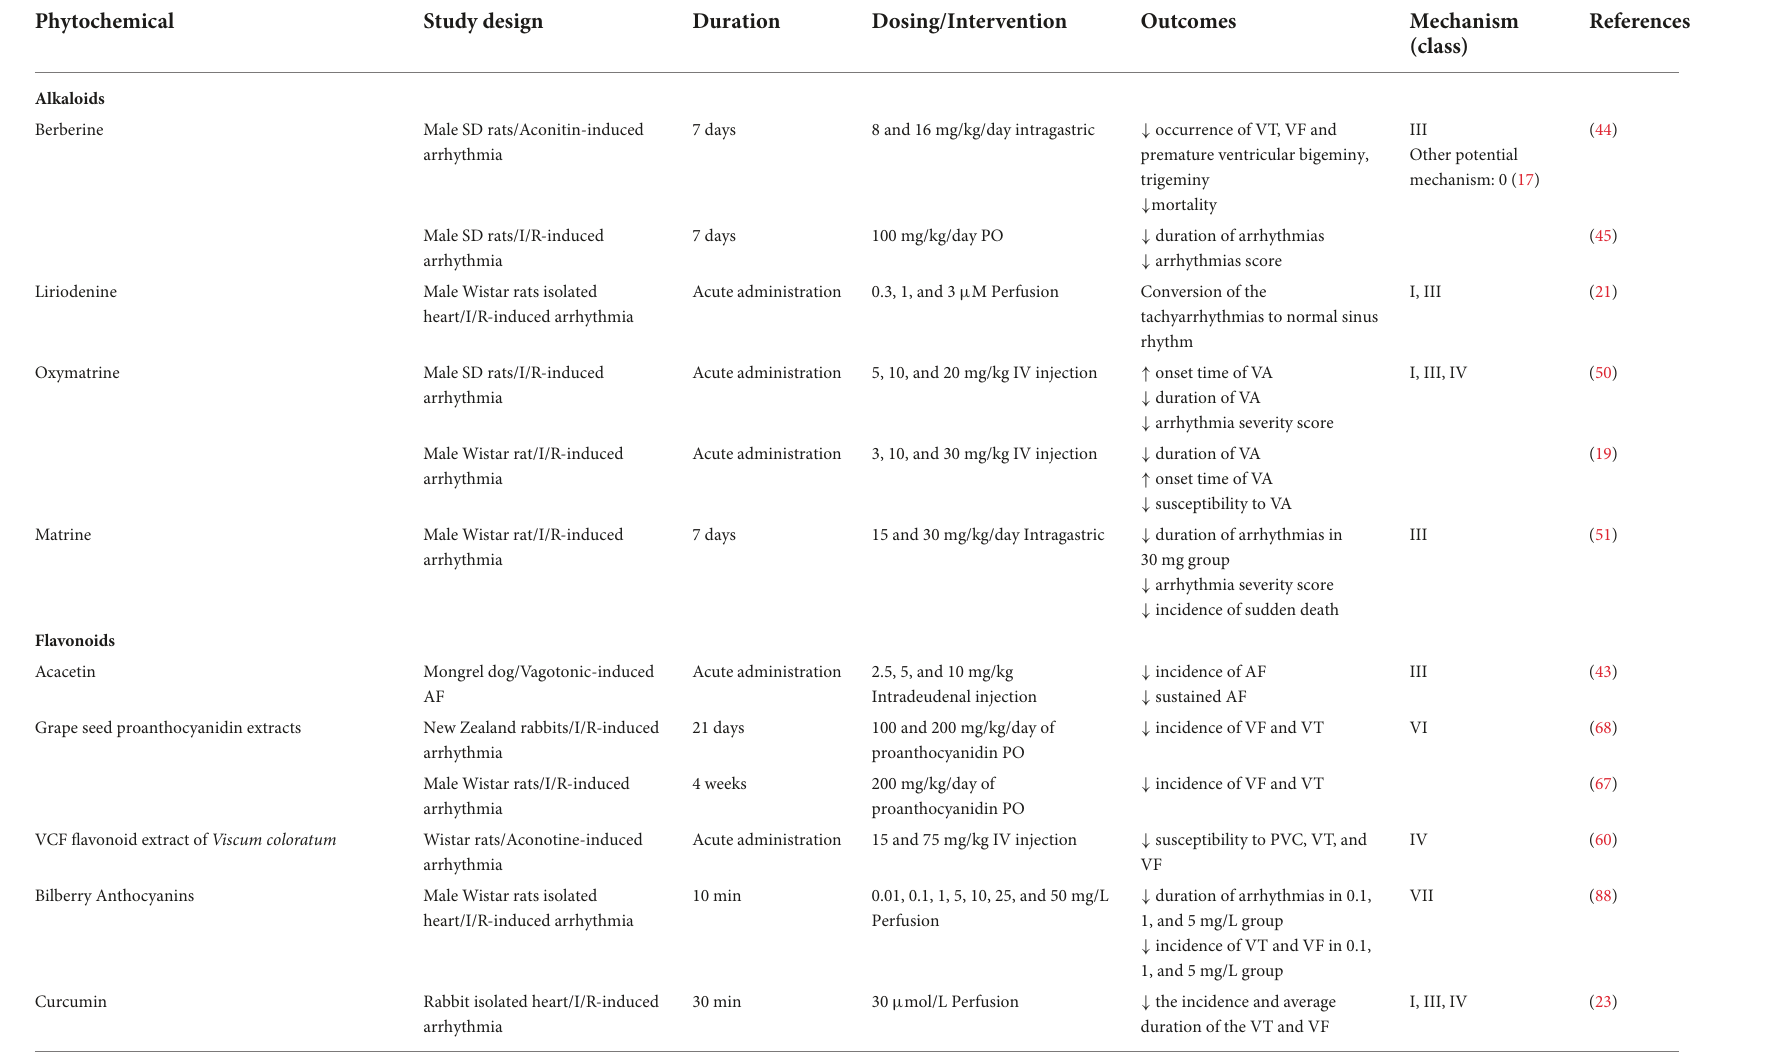
TABLE 3 Phytochemicals with antiarrhythmic effects and their mechanism of